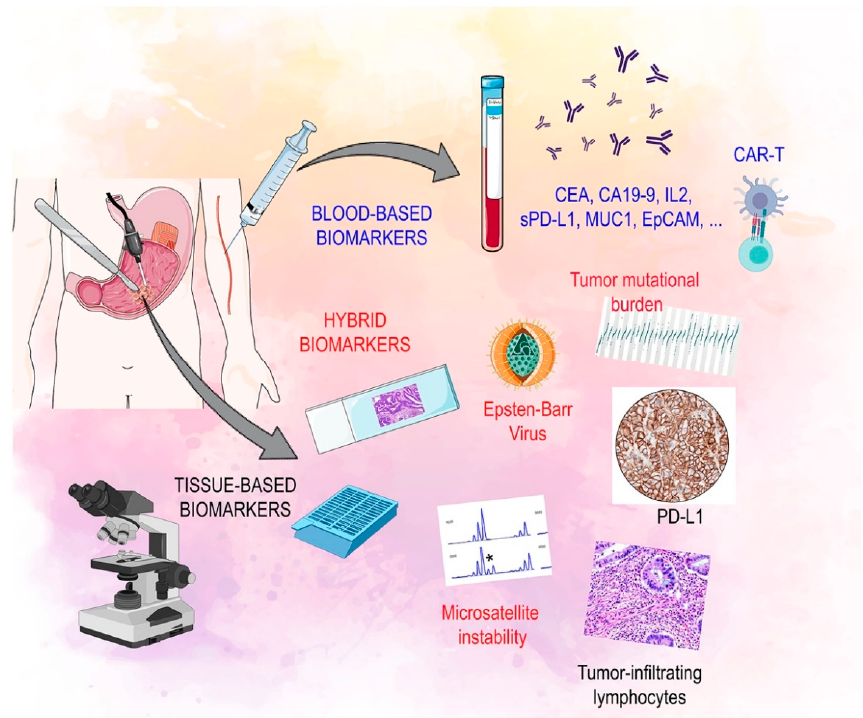
Figure 1. Biomarkers of response to immunotherapy: soluble, tissue based and hybrid. Legend: CAR-T: chimeric antigen receptor-T cell, CA 19.9: carbohydrate antigen 19.9, CEA: carcinoembryonic antigen, EPCAM: epithelial cell adhesion molecule, IL2: interleukin 2, MUC1: mucin 1, cell surface associated, PD-L1: programmed death-ligand 1, s PD-L1: serum programmed death-ligand